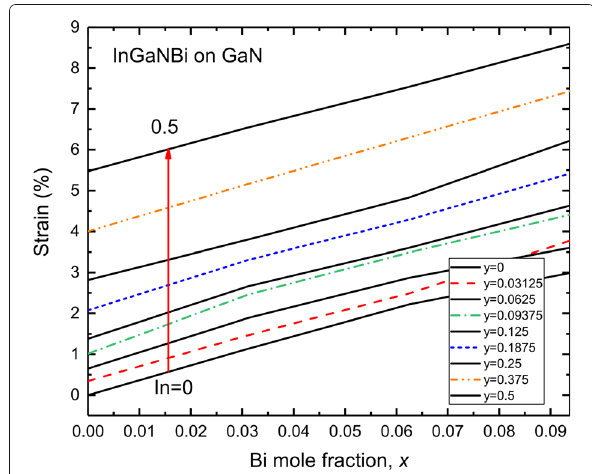
Fig. 6 Strain of InGaNBi alloys on GaN substrate at various In (0–0.5) as a function of Bi fraction. Positive values of strain indicate InGaNBi is under compressive